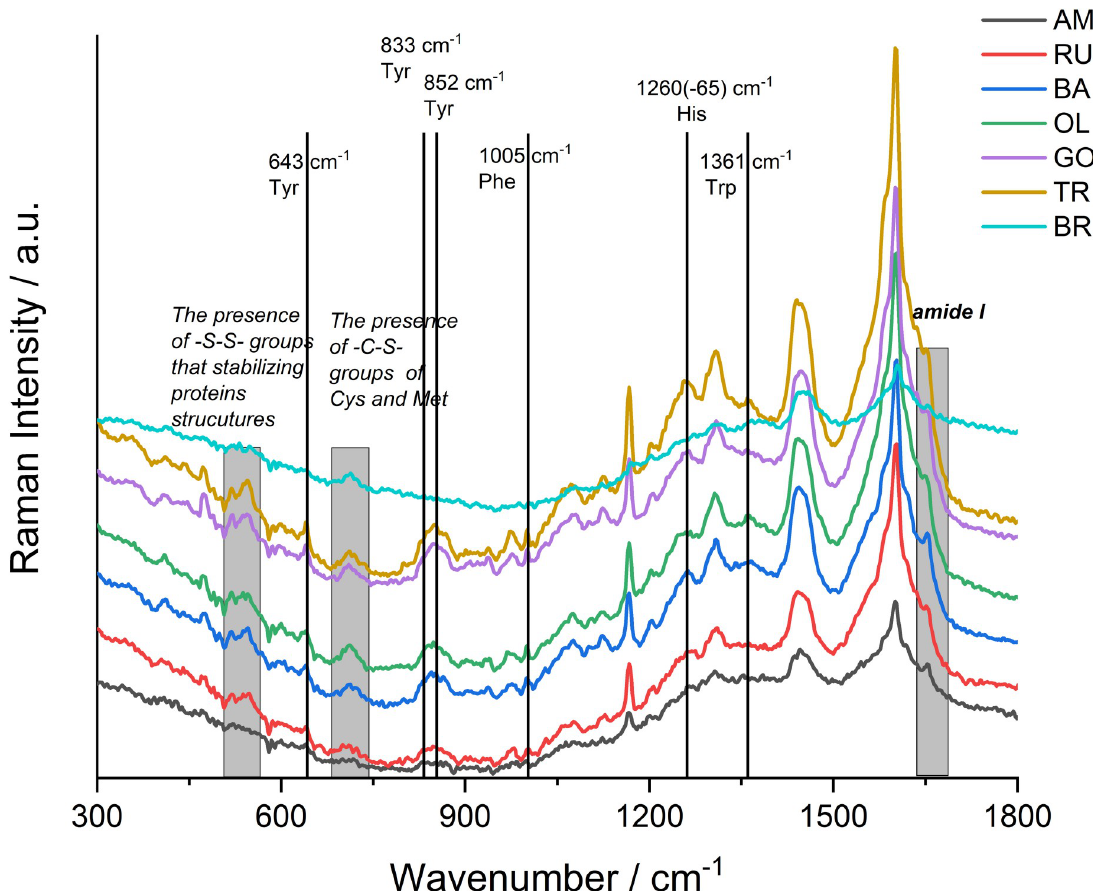
Fig 4. FT-Raman spectra of pollen samples of selected Betula pendula from various localizations in Malopolska region. RU–Ruczaj, BA–Batowice, AM–al. Mickiewicza, OL–Olkusz, TR–Trzebinia, GO- Gorlice, BR—Brunary. The wavenumbers of aromatic amino acids, as well as typical bands from protein structures, are pointed. Each spectrum is an average of at least 6 separate measurements. SD <